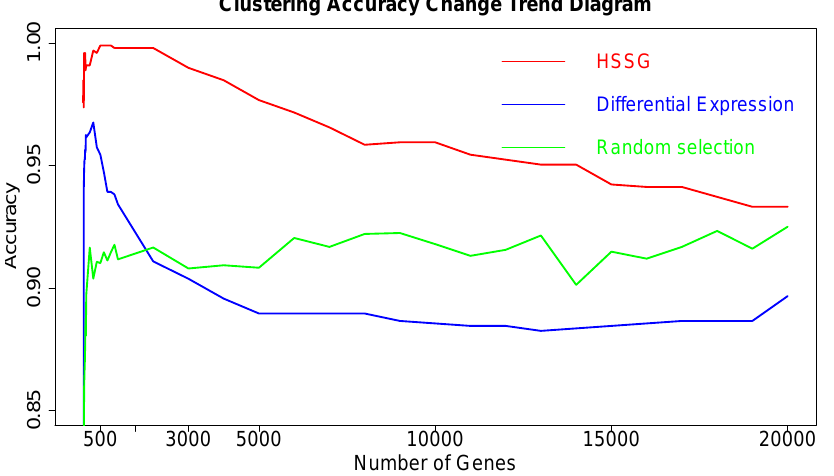
Figure 8. The changing curve of the accuracy of three different methods in identifying three cancer subtypes.